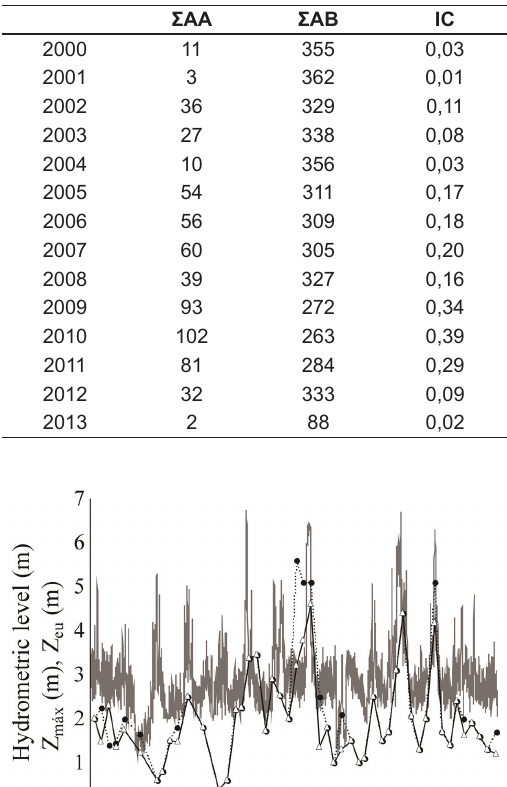
Table 1. Attributes Pulse of the daily hydrometric levels in the Upper Paraná River ( Σ AA = days of potamophase, Σ AB = days of limnophase, IC = connectivity index) for every year. The values for 2013 corresponds only to the month of March.